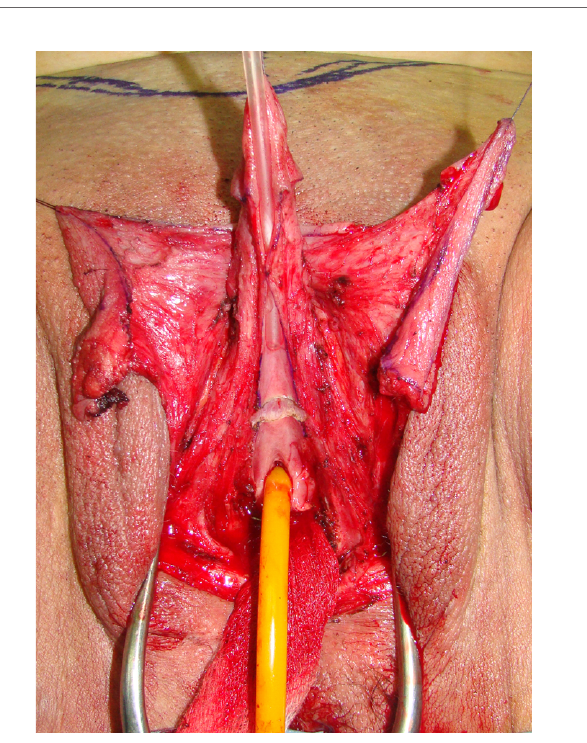
FIGURE 3 | Clitoris is maximally lengthened by dividing of suspensory ligaments, dorsally.